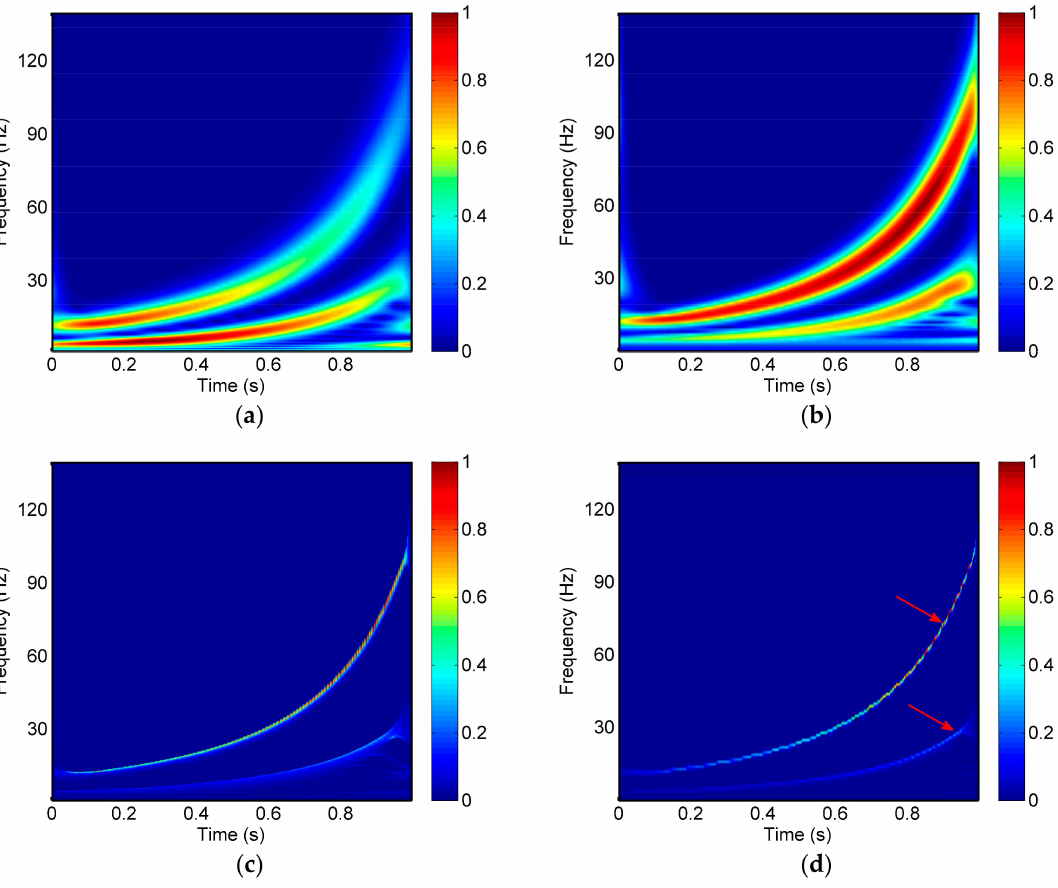
Figure 4. Time-frequency spectra of the double hyperbolic chirped signal based on ( a ) CWT, ( b ) GST, ( c ) SSCWT, and ( d )